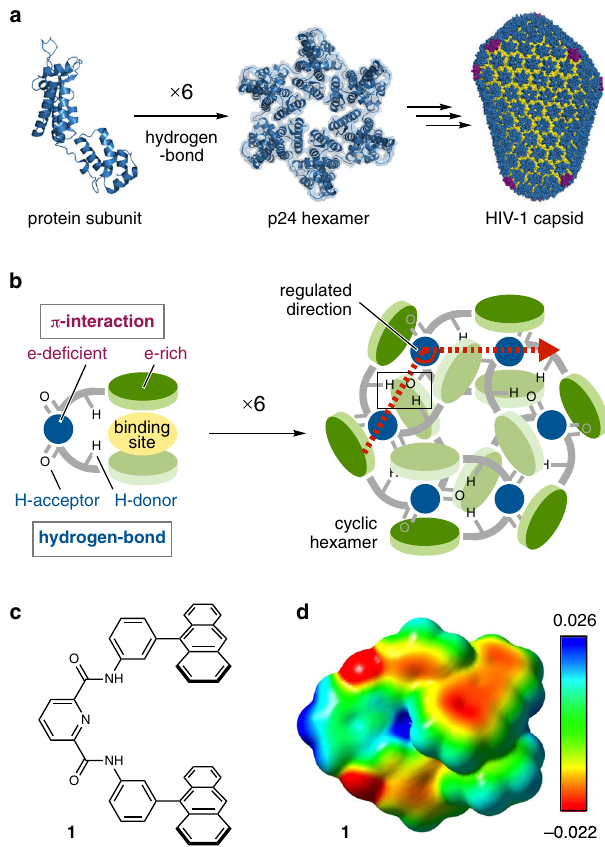
Fig. 1 | Schematic representations of self-complementary assembly. a Six pro- tein subunits assembled through multiple hydrogen bonds to form a p24 protein hexamer of the HIV capsid. b Schematic representation of the dual interaction system for the construction of a self-complementary macrocycle in this work. c Chemical structure of anthracene-based molecular tweezers 1 and d its ESP map calculated by the density functional theory (DFT) method at the B3LYP-D3/6- 31G(d,p)